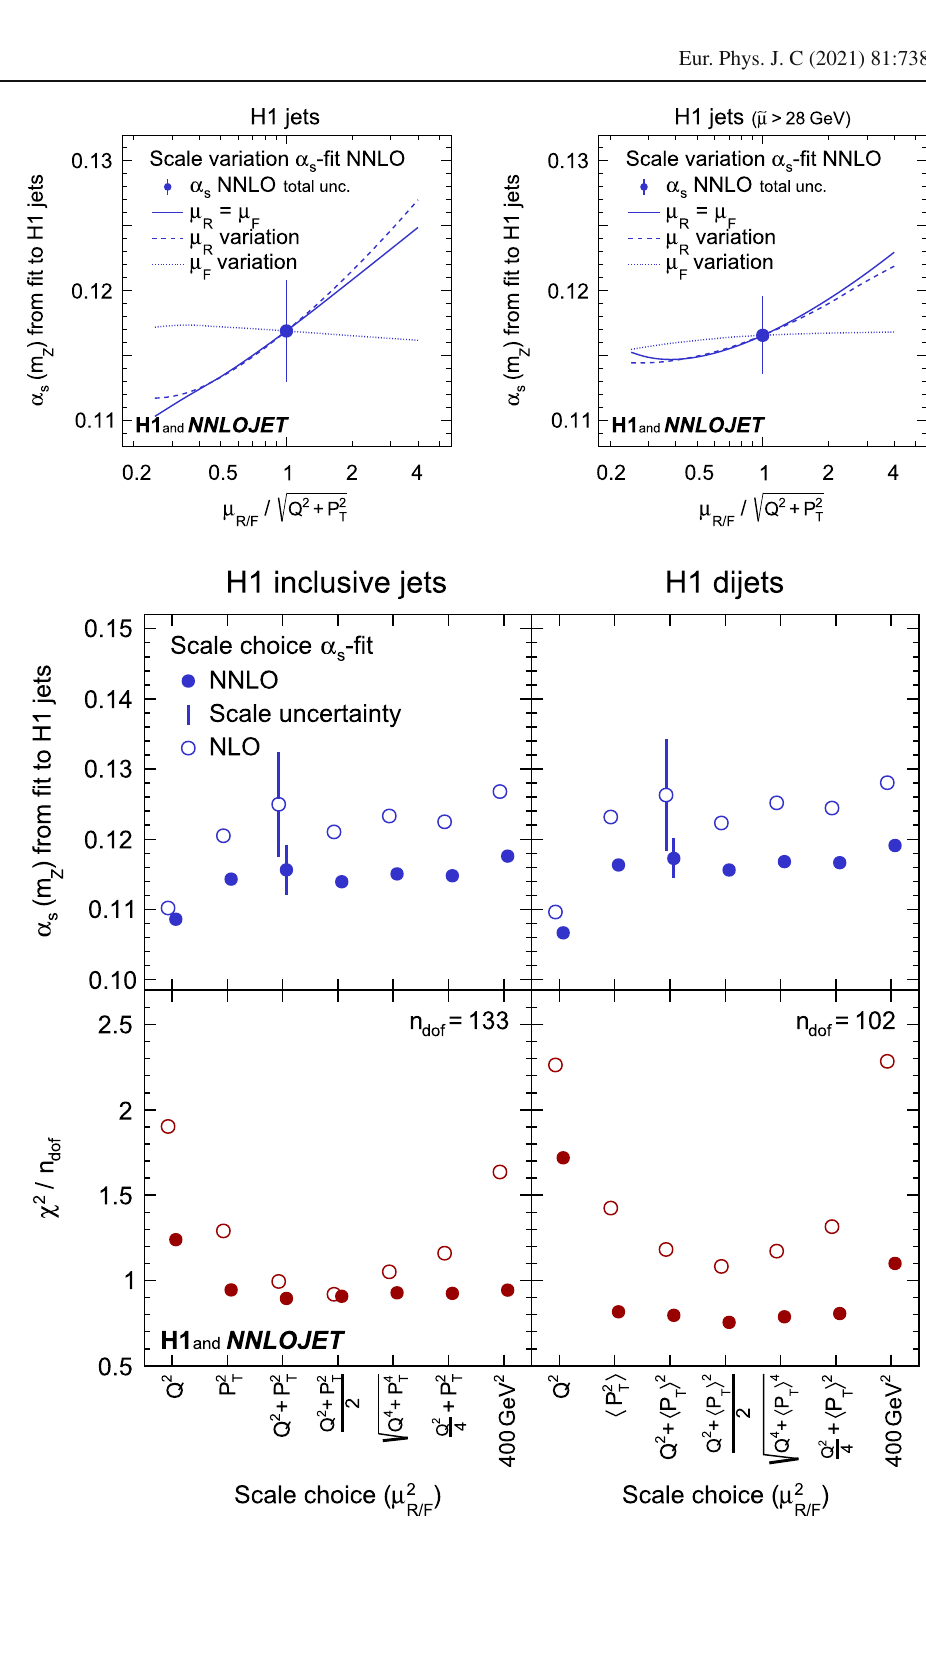
Fig. 8 Values of α s ( m Z ) obtained for different definitions of the renormalisation and factorisation scales ( μ R and μ F ) in separate fits of inclusive jet and dijet data. The lower panels show χ 2 / n dof of the fits. The open circles display results obtained using NLO matrix elements. The vertical bars indicate the scale uncertainties displayed together with the nominal scale